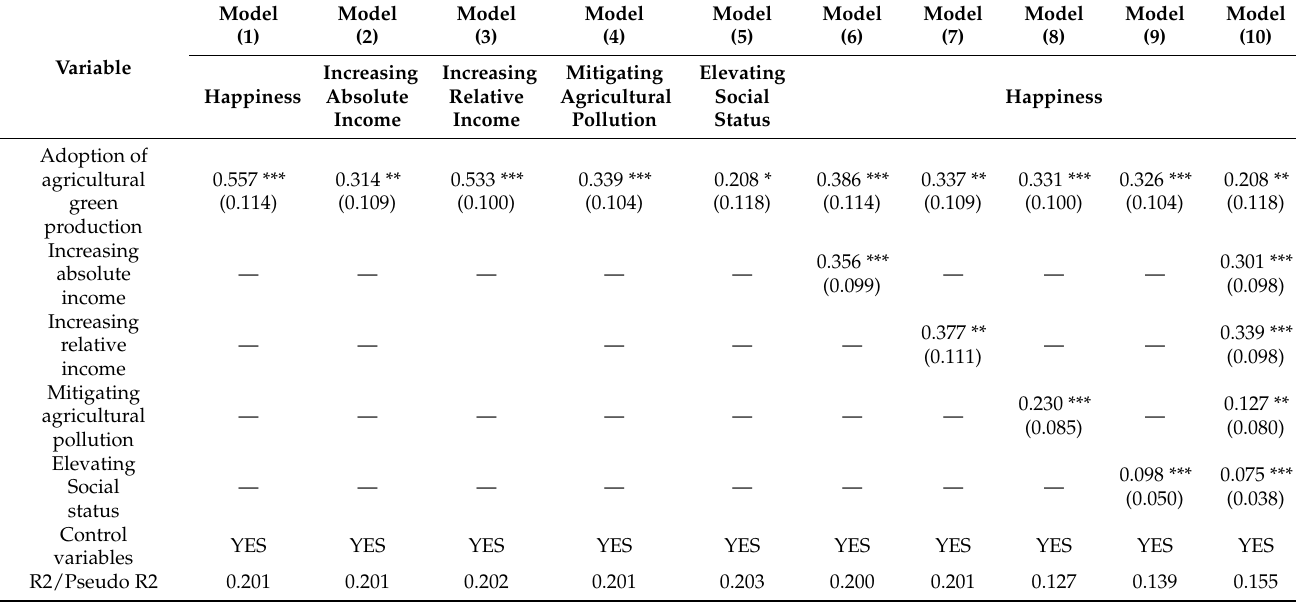
Table 7. Robustness testing results by partial